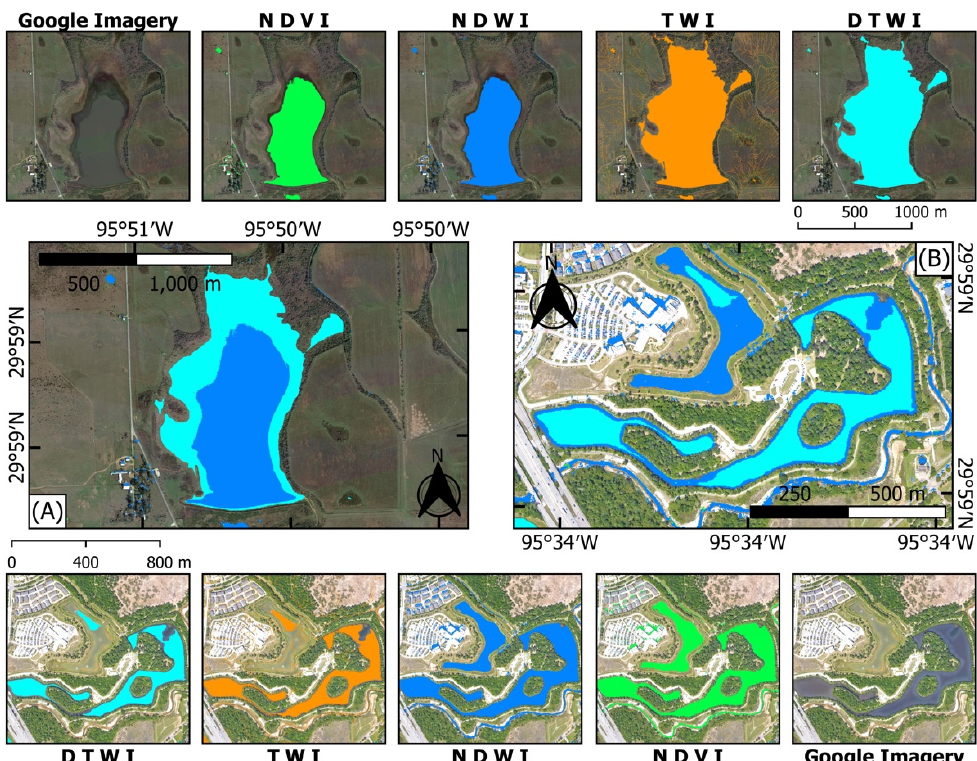
Figure 7. The comparison for the two typical cases of delineation area of the four indices ( A ) the area delineated by the optical imagery approach is bigger than the topographic approach ( B ) the area delineated by the optical imagery approach is smaller than the topographic approach.